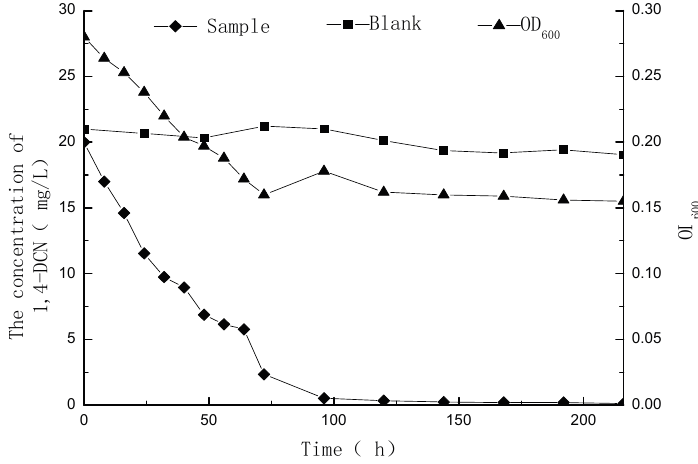
Figure 2. Microbial degradation of 1,4-DCN at an initial concentration of 20